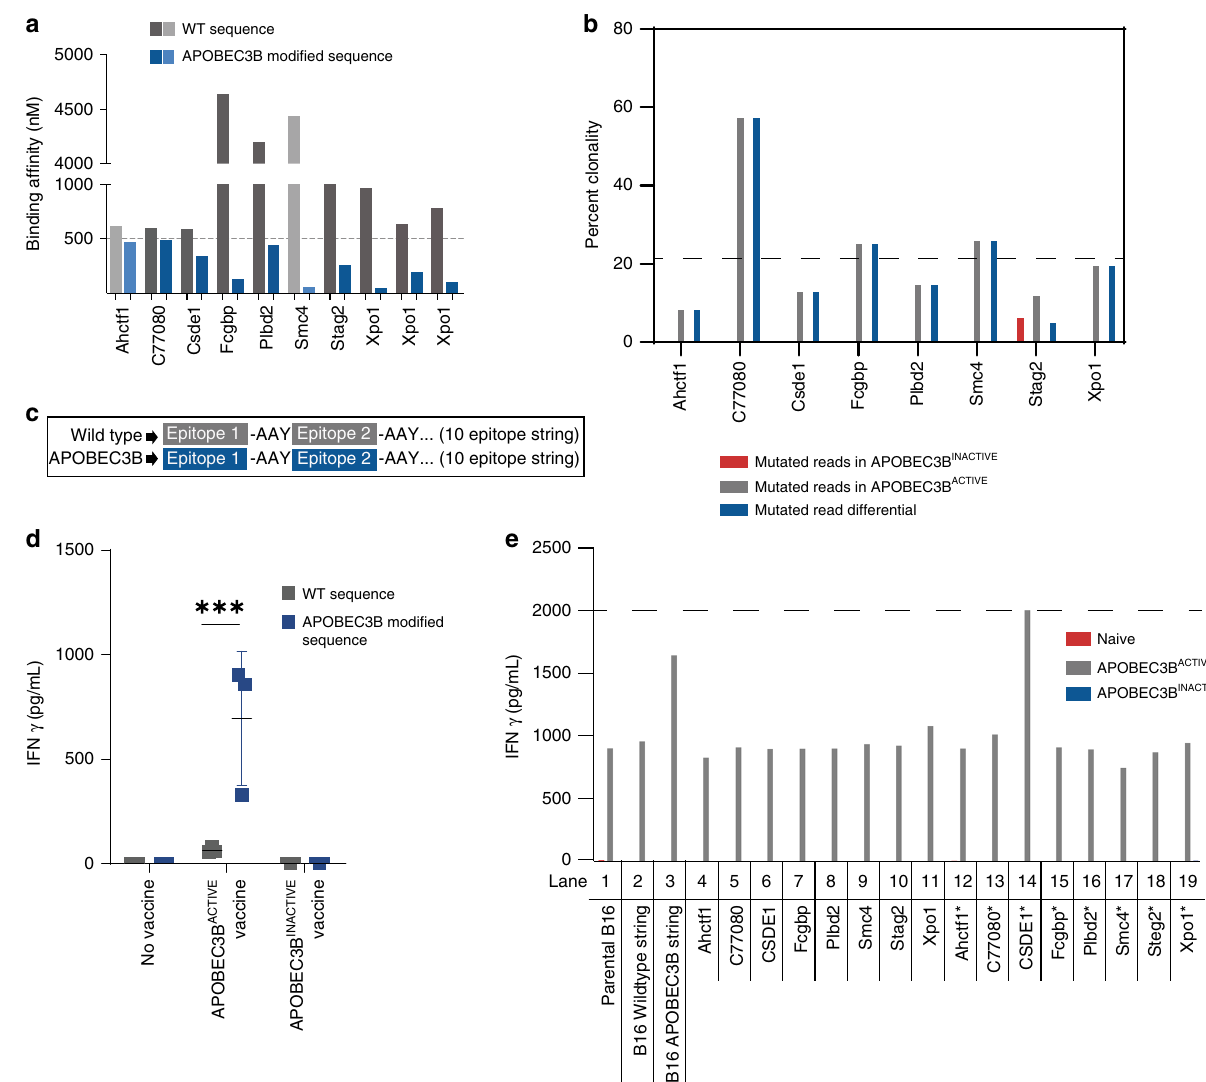
Fig. 4 Mutated peptides with differential MHC binding were identi fi ed as potential heteroclitic neoepitopes. a The seven genes leading to ten peptides that showed differential MHC I binding between the wild-type and mutated peptide are shown. The threshold for binding af fi nity was set at 500 nM with weak binding being above 500 nM and strong binding being below 500 nM. b The clonalities of the genes in ( a ) is shown for both the B16- APOBEC3B ACTIVE and B16-APOBEC3B INACTIVE cell populations. c Expression plasmids were constructed that encoded either all ten wild type (wild-type epitope string) or all ten mutated peptide sequences (APOBEC3B epitope string) with AAY spacers between each peptide to enhance cleavage and presentation. d C57Bl/6 mice were left unvaccinated (no vaccine) or were vaccinated with cell lysates of B16-APOBEC3B ACTIVE , or B16-APOBEC3B INACTIVE cells, with no added α -PD1 ICB, as described in Fig. 2a ( n = 3 mice per group). Splenocytes from these mice were cocultured with parental B16 tumors that overexpressed either the wild type, or APOBEC3B-modi fi ed, epitope string ( c above) and IFN- γ levels in the supernatants were measured by ELISA. Data points represent three biologic replicates. Error bars indicate mean and SD. A two-way ANOVA was used followed by Tukey ’ s multiple comparison test. *** p ≤ 0.001. e C57Bl/6 mice were left unvaccinated (Naive) or were vaccinated with cell lysates of B16-APOBEC3B ACTIVE , or B16-APOBEC3B INACTIVE cells, with immune checkpoint blockade ( α PD-1) as described in Fig. 2a. Splenocytes from these mice were cocultured with (lane 1) parental B16 tumors, or with parental B16 cells expressing (lane 2) wild-type string of epitopes ( c above), or (lane 3) the APOBEC3B string of epitopes ( c above), or expressing the individual wild-type epitopes (lanes 4 – 11), or the individual mutated epitopes (lanes 12 – 19). IFN- γ levels in the supernatants were measured by ELISA and are shown from splenocytes from the naïve (red), B16-APOBEC3B ACTIVE (gray), or B16-APOBEC3B INACTIVE vaccinated mice (blue). Dashed line indicates upper limit of detection. Data shown represent single well results from pooled splenocytes from three mice per vaccination group which are representative of multiple